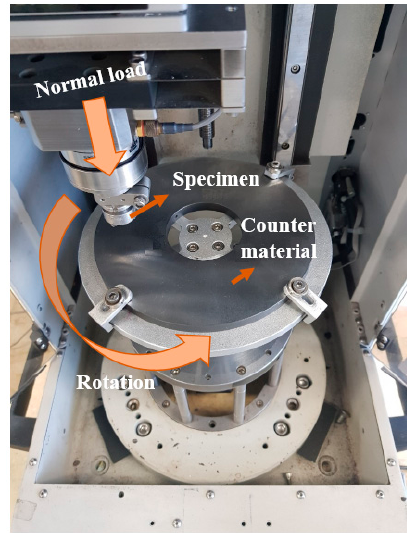
Figure 2. Experimental set-up for the pin-on-disk test.